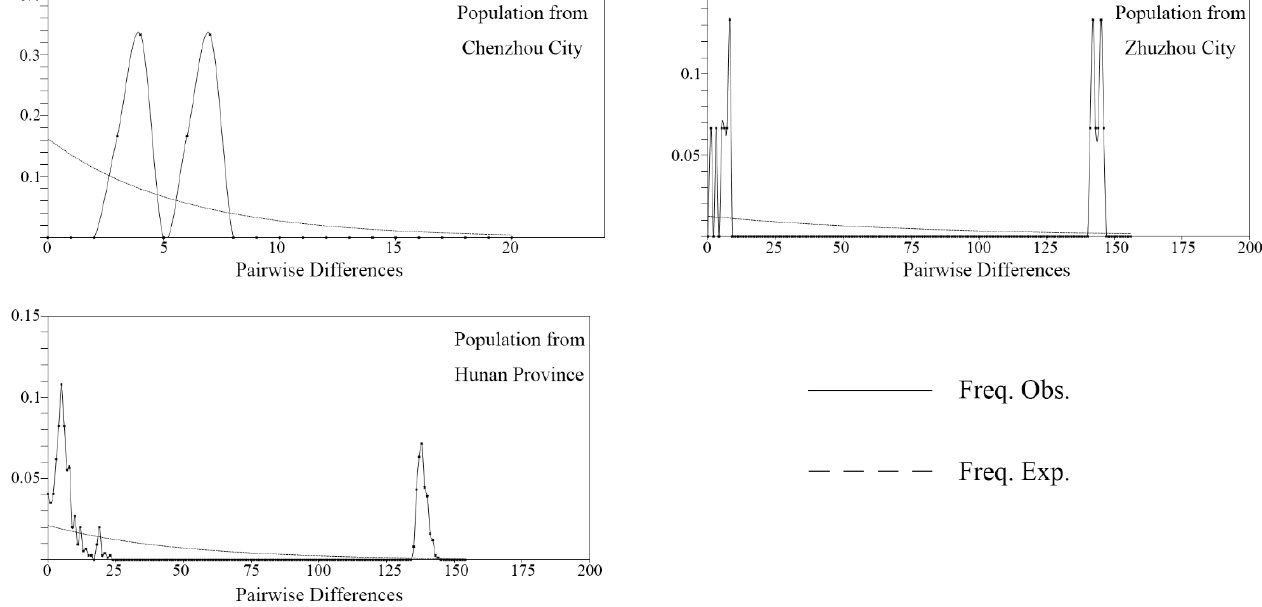
Figure 5. Maps of the mismatch distribution of population from seven cities in Hunan Province, based on mitochondrial genes COI + COII + 12S + 16S + ND1 . The abscissa represents the number of pairwise distances. The ordinate represents the number of observations. The lines represent the expected (dashed) and observed (smoothed) frequencies of pairwise differences under sudden lineage expansion.